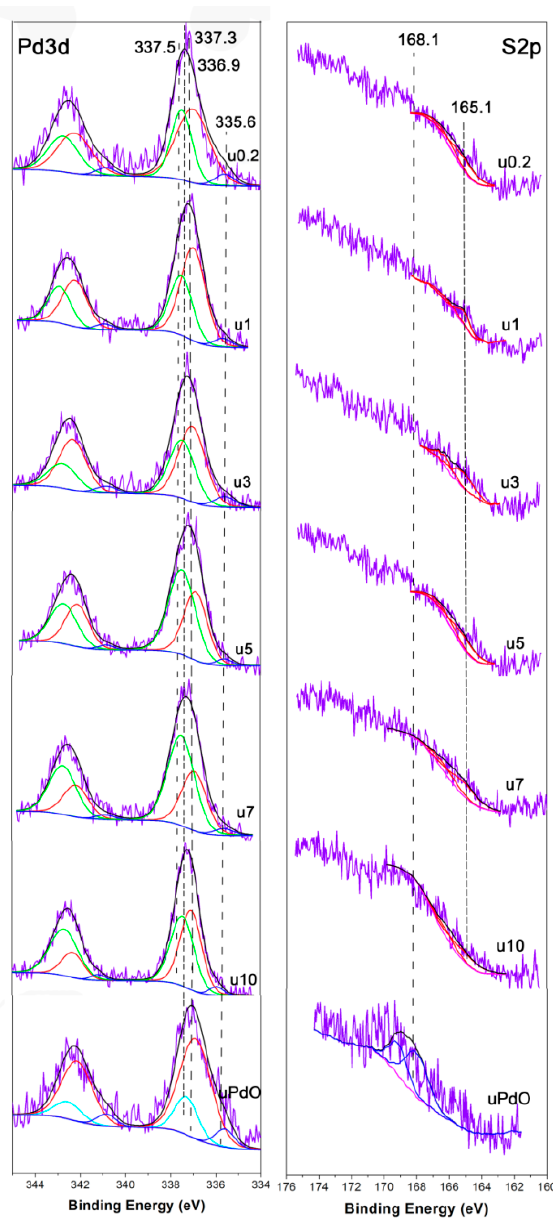
Figure 7. XPS Pd 3d and S2p of the used catalysts with different H 2 S concentration.